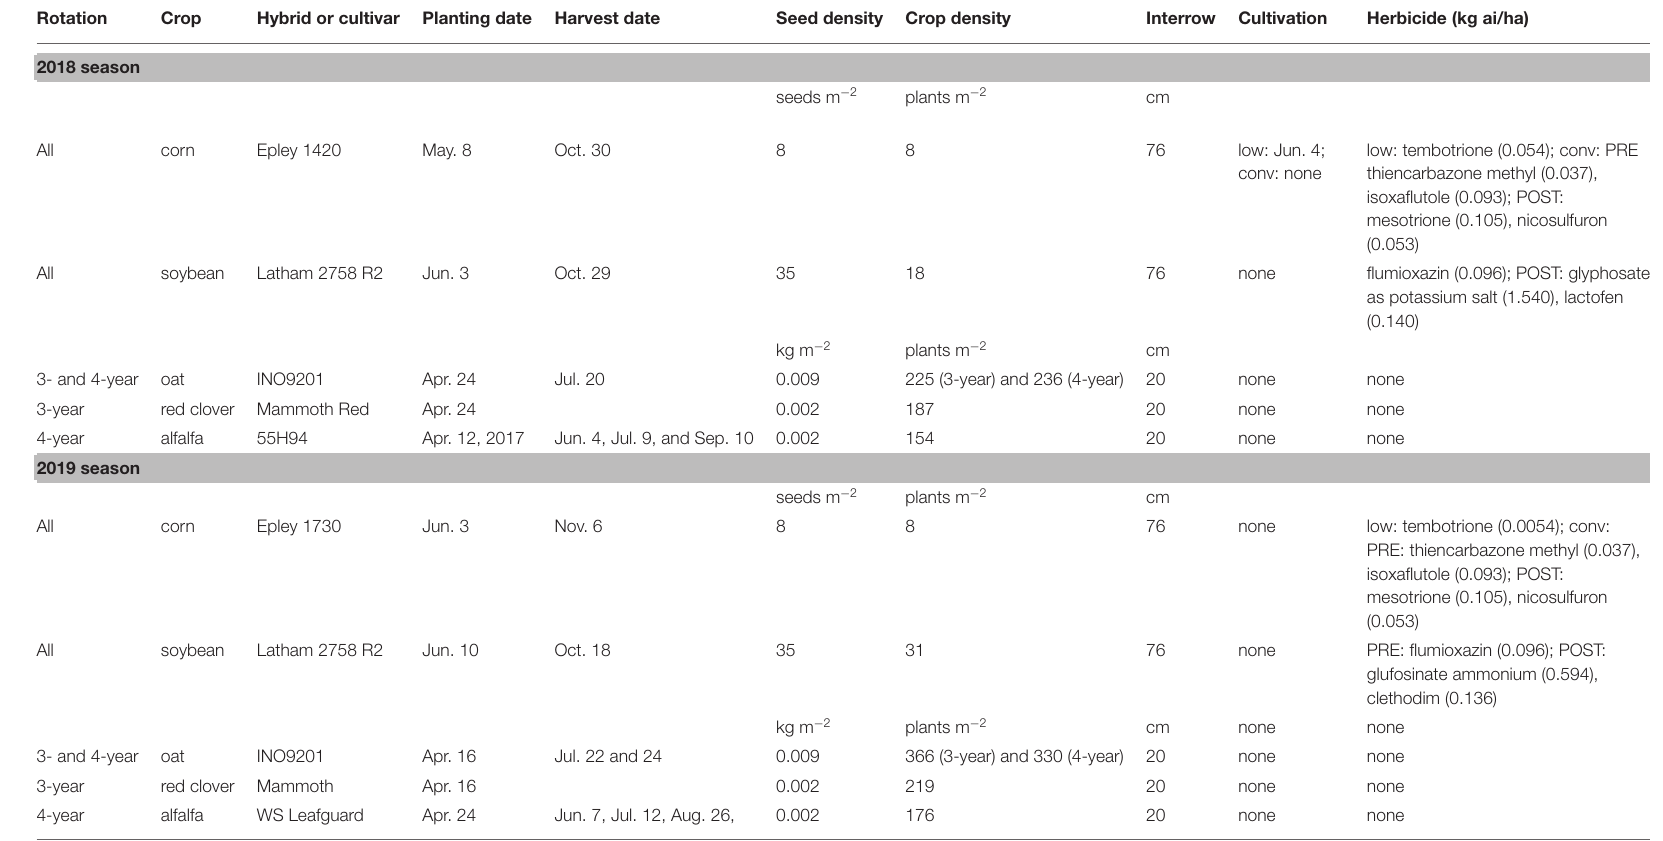
TABLE 2 | Crop varieties, and dates and rates for management operations in 2018 and 2019. Rotation Crop Hybrid or cultivar Planting date Harvest date Seed density Crop density Interrow Cultivation Herbicide (kg